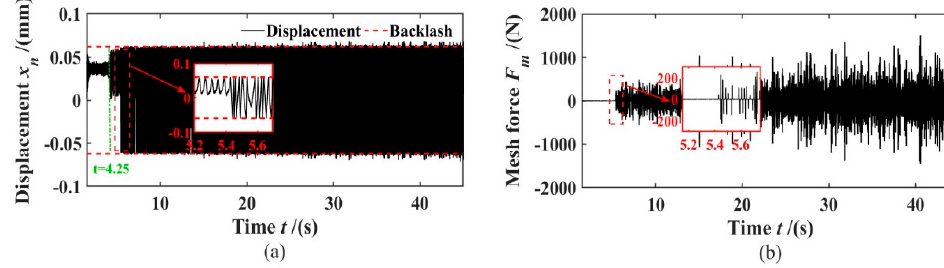
Figure 16. Gear rattling strength: ( a ) 1st gear; ( b ) 1st gear pre-selection 4th